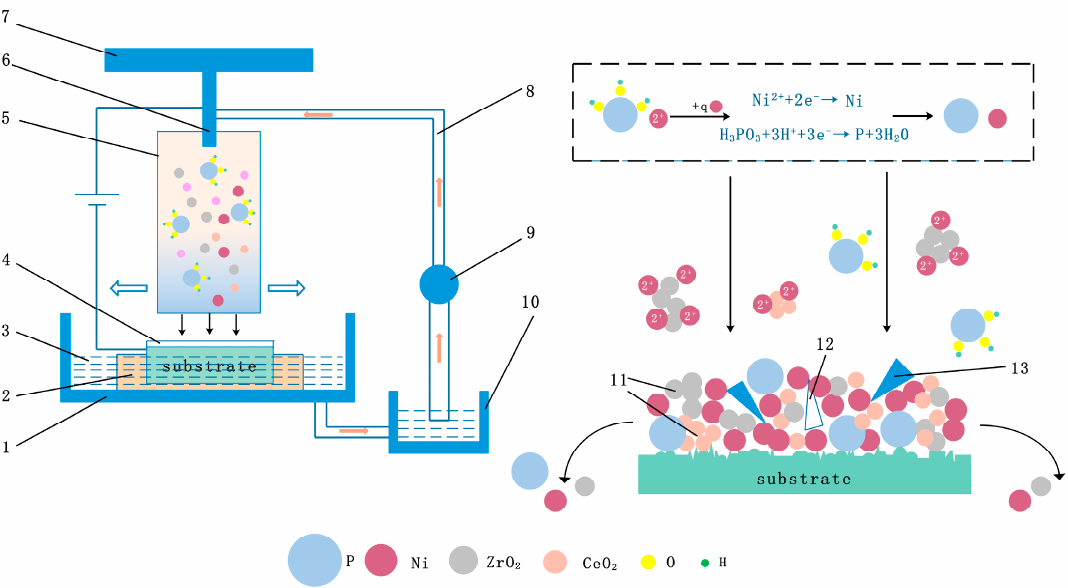
Figure 1. Experimental schematic of jet-electrodeposition. 1—seal groove; 2—clamping tool; 3—plating solution; 4—coating; 5—nozzle; 6—nickel rod; 7—machine tool spindle; 8—catheter; 9—sinking pump; 10—reservoir; 11—agglomeration phenomenon; 12—hump 13—pit.